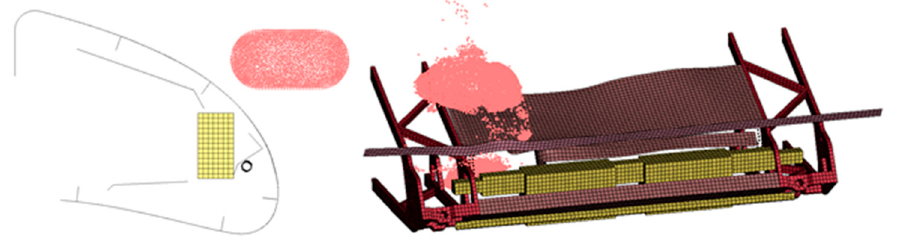
Figure 32. Bird strike simulation. Left: Impact configuration; right: Interaction of bird with internal structure.